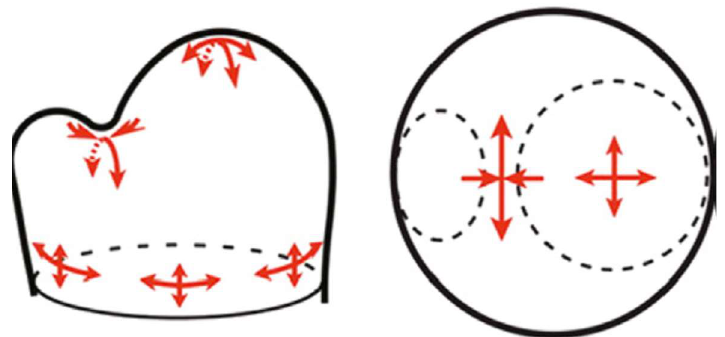
Figure 7. Stress vectors in the shoot apical meristem. The suggested changing meristem stress patterns cause auxin depletion in the boundary region as primordia form [26]. Note that the magnitude and direction of the stress vector are strongly anisotropic (red arrows) in the boundary region between the primordium and shoot apical meristem apex. Reprinted from [85] with permission from AAAS).